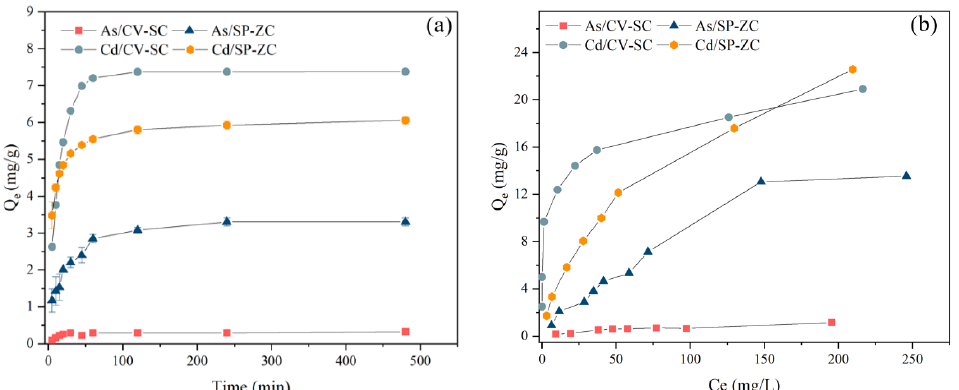
Figure 4. Effects of ( a ) contact time and ( b ) initial concentration on biosorption for As(V) and Cd(II) by NaCl modified C. vulgaris and ZnCl 2 modified S. platensis . Table 1. Kinetic model parameters of As(V) and Cd(II) biosorption onto the NaCl modified C. vulgaris and S.